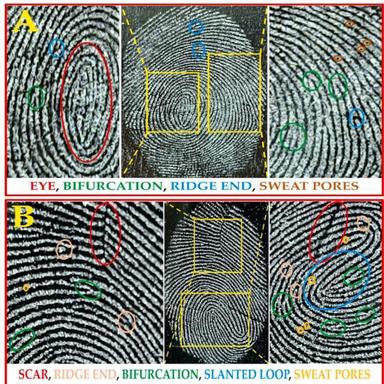
Visualization of type-I, type-II, and type-III ridge patterns of latent fingerprints on non-porous (A) aluminium and (B) glass surfaces using the prepared SCD5 NPs.